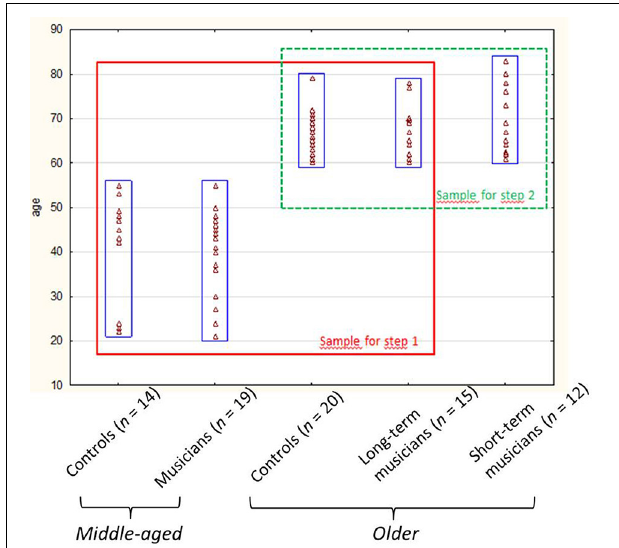
FIGURE 1 | Dispersion graph showing the participants’ ages in Study 1 (red square) and 2 (green square).